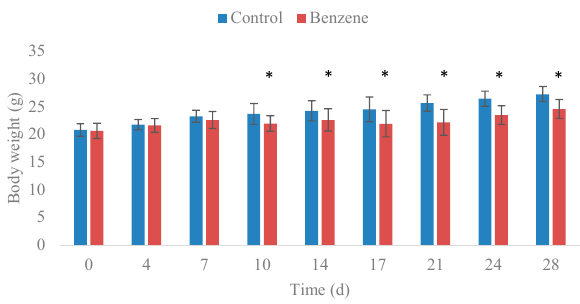
Figure 1. Effect of benzene exposure on body weight (g). The data are presented as the mean ± SD. n = 12 for each group. * p < 0.05. Table 1. Effect of benzene exposure on organ coefficient.